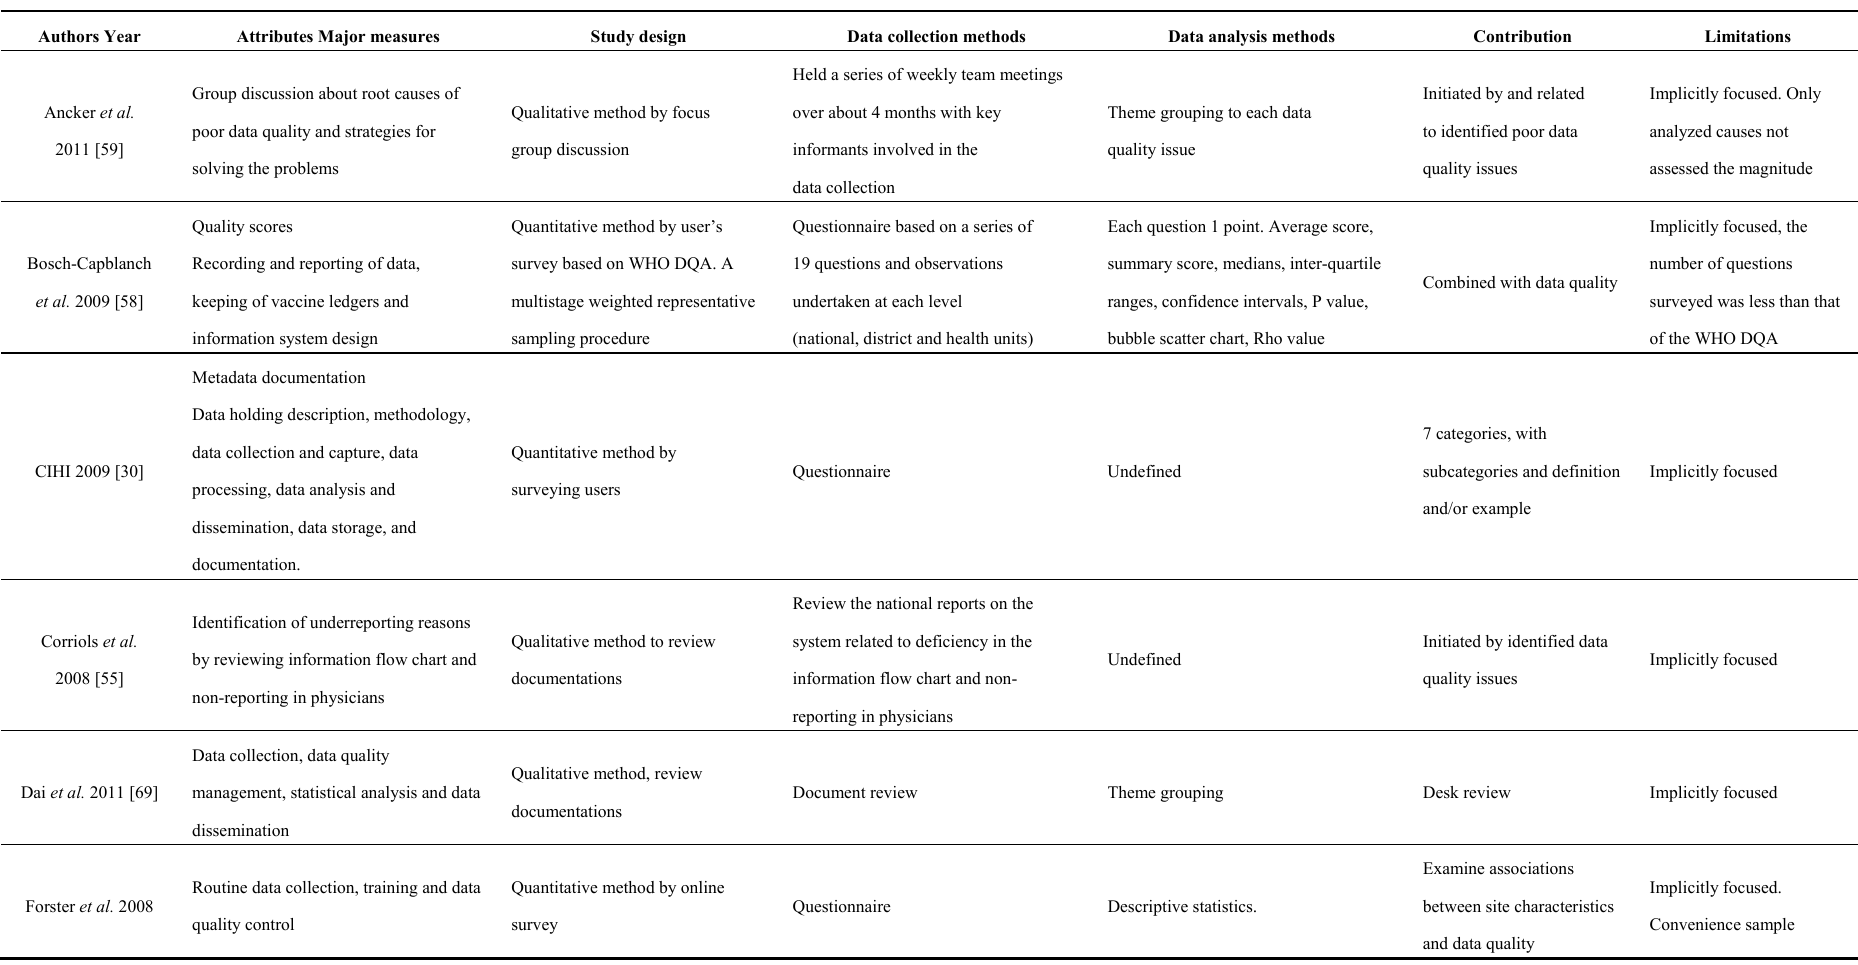
Table A3. Characteristics of the methods for assessment of data collection process reported in the 16 publications included in the review. Authors